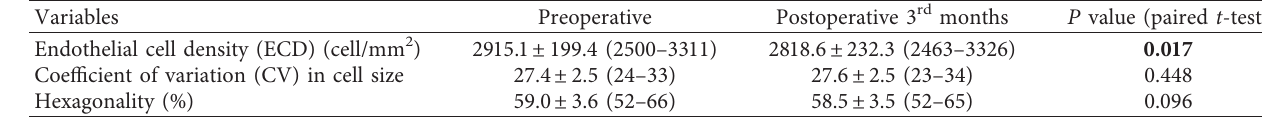
Table 3: Endothelial cell assessment: ECD and morphological features.